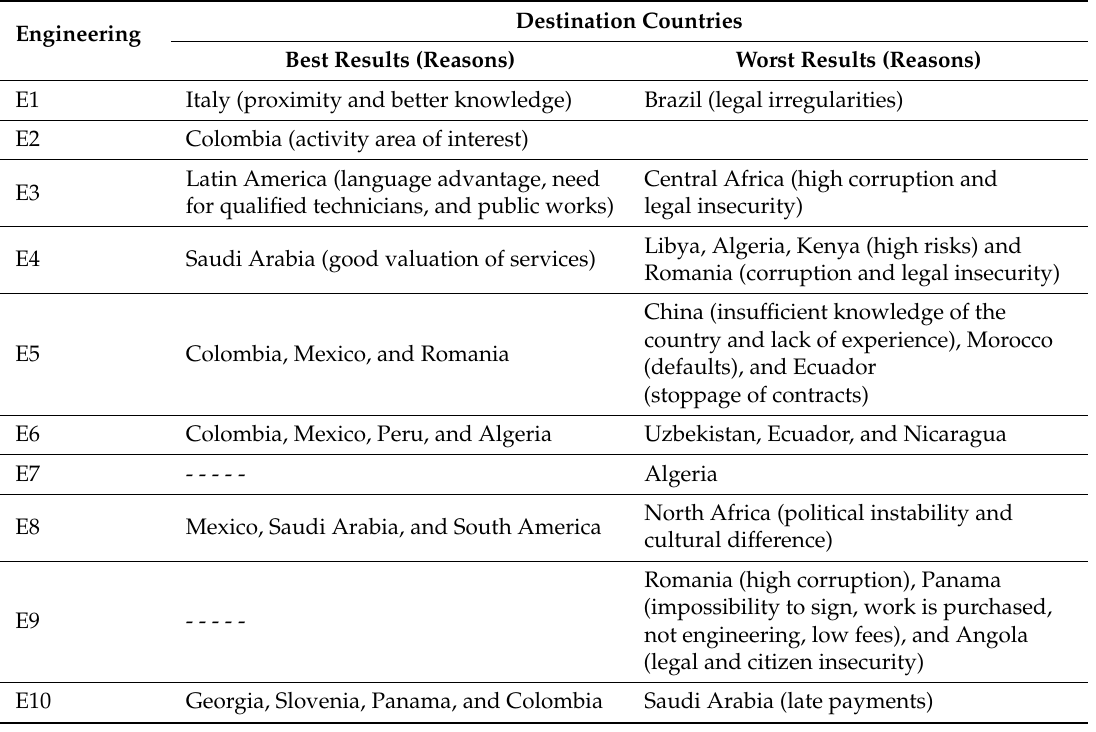
Table 7. Destination countries and